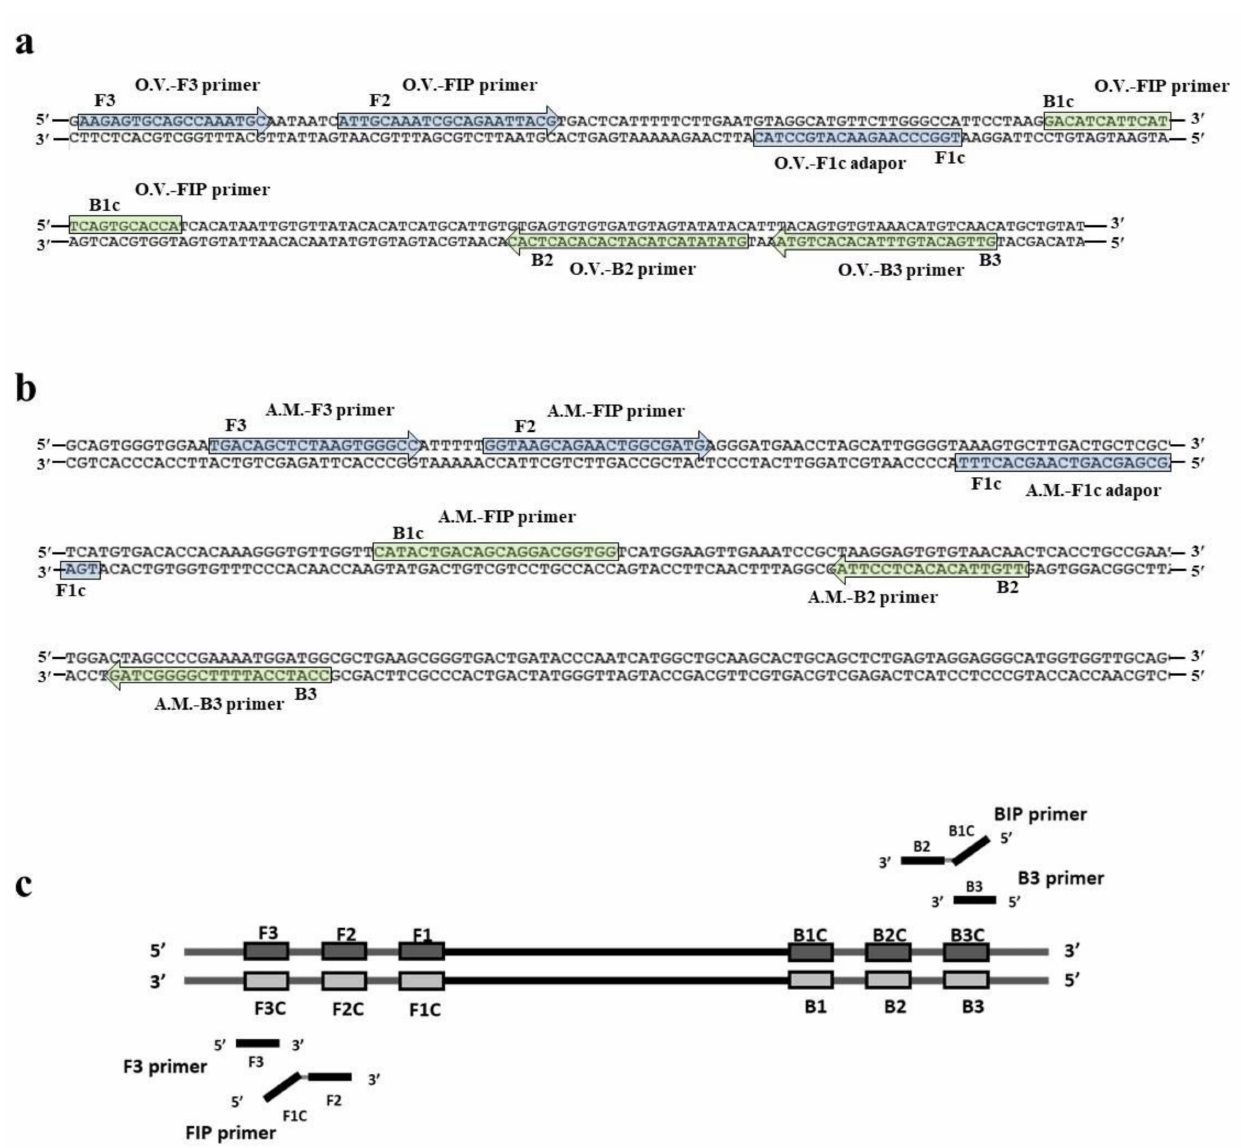
Figure 1. Nucleotide sequence used to design the primers for loop-mediated isothermal amplification (LAMP). The square boxes indicate the recognition sequences of the primers. The right arrow indicates that a sense sequence was used for the primers. The left arrow indicates that a complementary sequence was used for the primer. ( a ) Primer sequences for Ostreopsis cf. ovata. ( b ) Primer sequences for Amphidinium massartii . ( c ) Schematic representation of the primers used in this study. Construction of two outer (F3 and B3) and two inner (forward inner primer (FIP) and backward inner primer (BIP)) primers for loop-mediated isothermal amplification